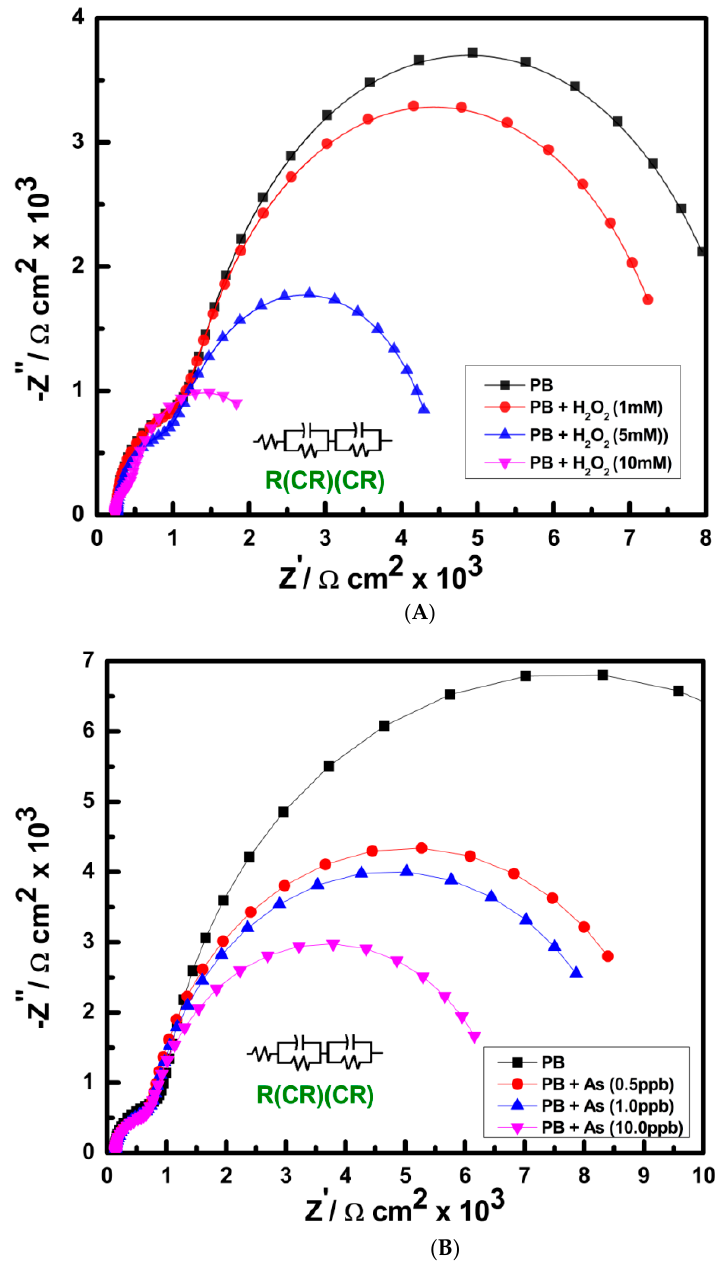
Figure 5. ( A ). Nyquist plot of the PB nanoparticle-modified electrode in the presence of varying concentrations of hydrogen peroxide. ( B ). Nyquist plot of the PB nanoparticle-modified electrode in the presence of varying concentrations of As(III).